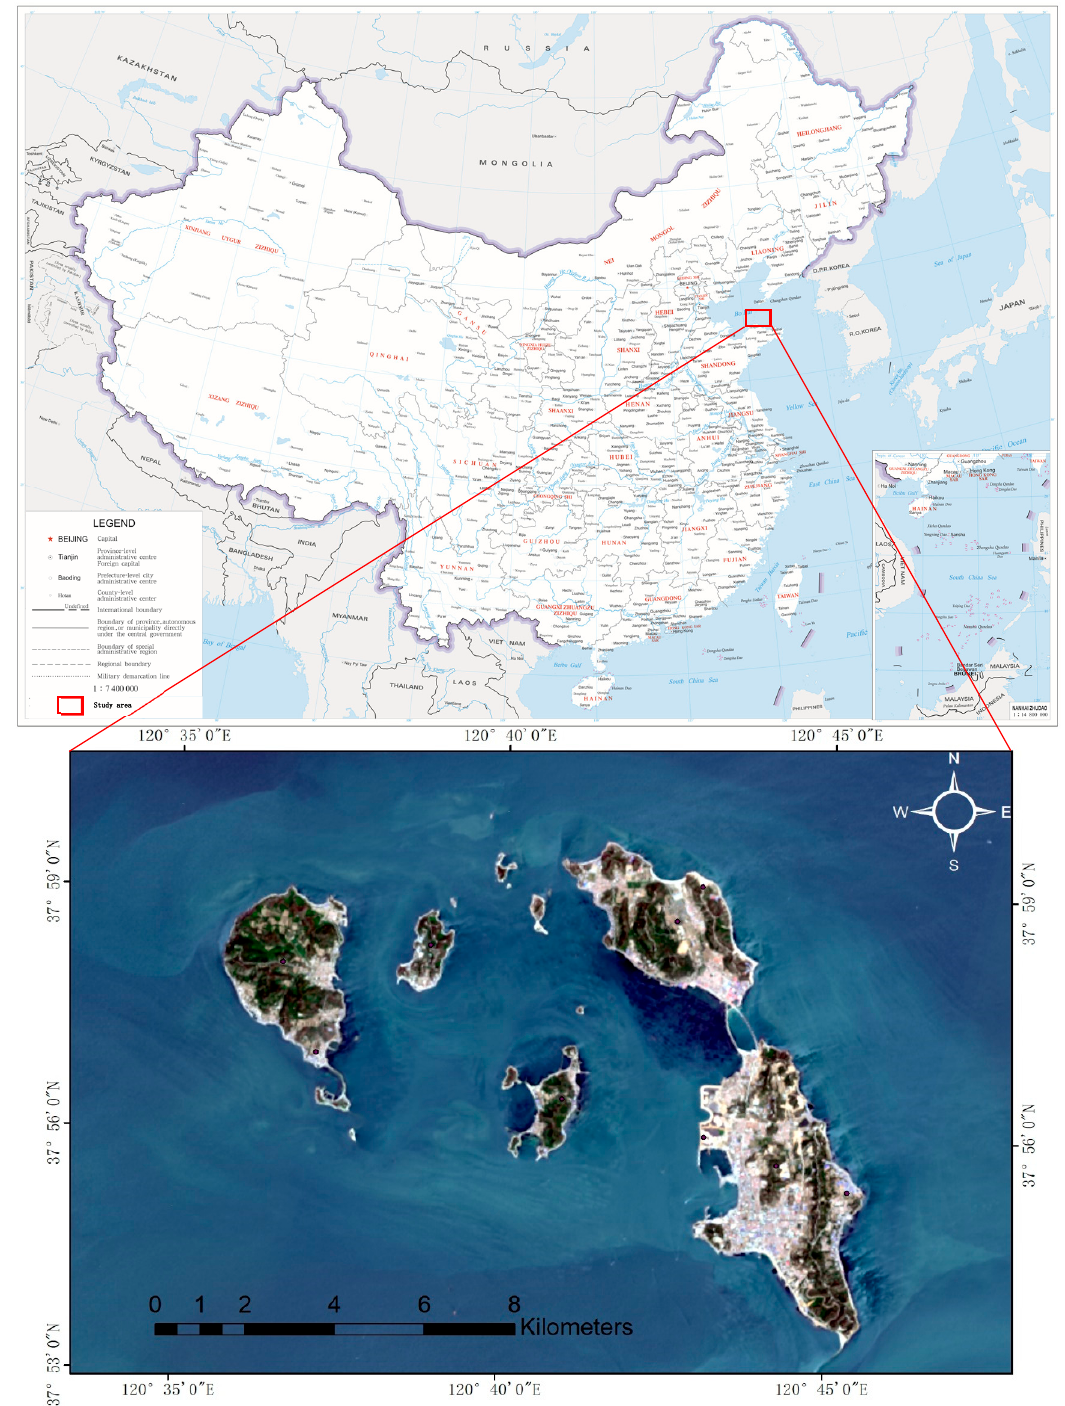
Figure 1. Location of the study area.